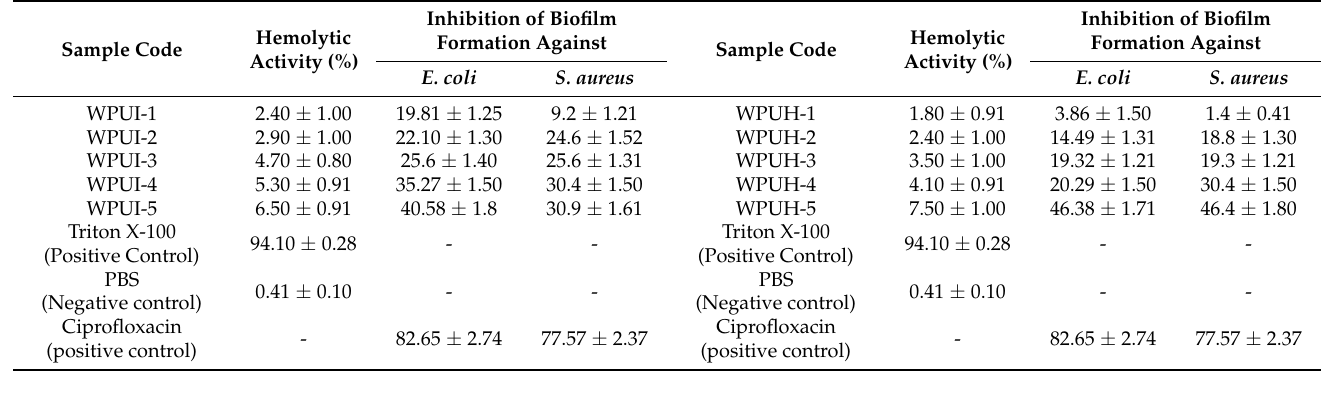
Table 3. Data of bioassays of WPUDs of WPUI and WPUH series.